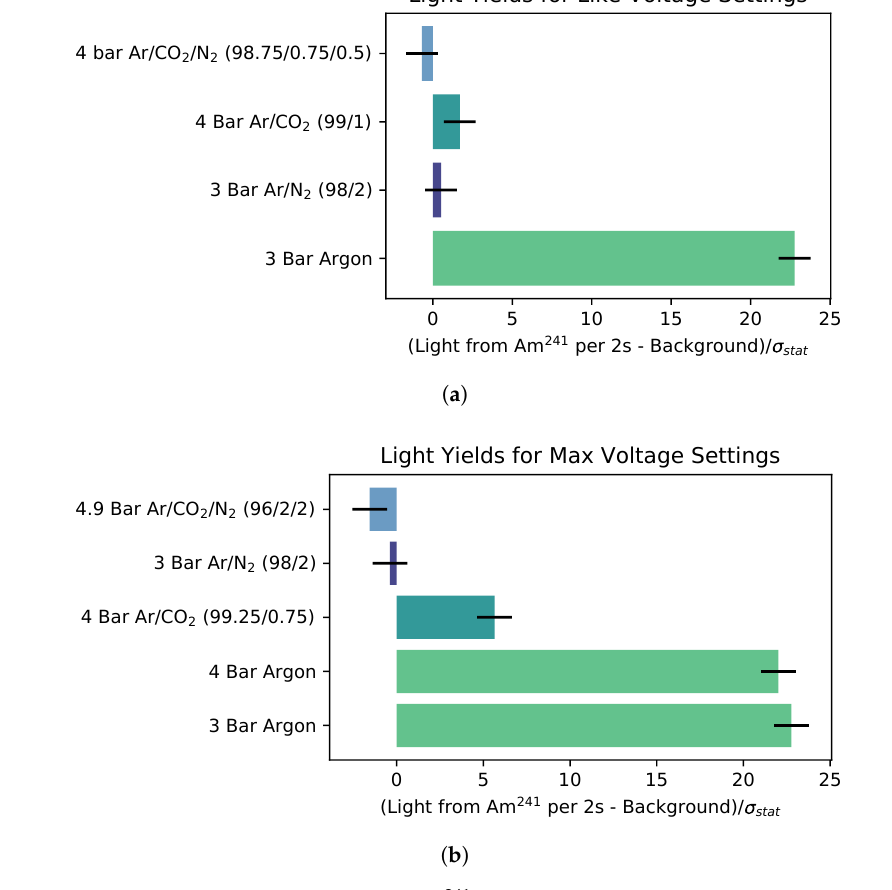
Figure 13. Light yield measured for an 241 Am source with different gas mixtures ( a ) at near constant anode and cathode voltages and ( b ) the maximal light yield achieved. Table 1 lists the voltages used during these measurements. Table 1. Voltage settings for the result plot shown in Figure 13: the top table shows the voltages used for the settings that are shown in Figure 13a, while the bottom table shows the settings used for the data shown in Figure 13b. The absolute pressure is